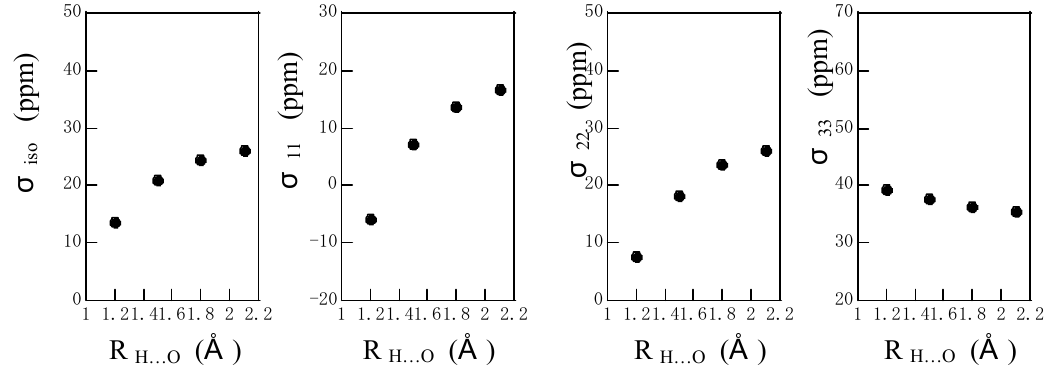
and 1 H chemical iso